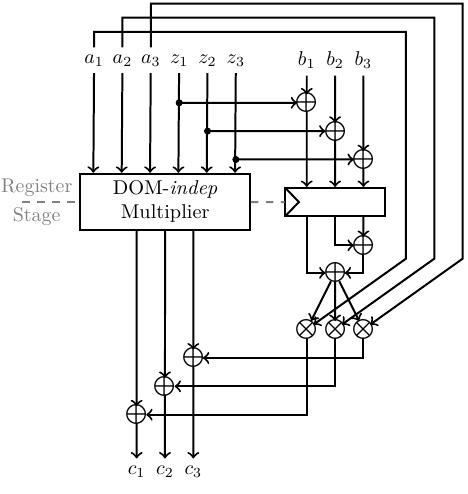
Figure 2: Architecture of DOM- dep for d = 2.